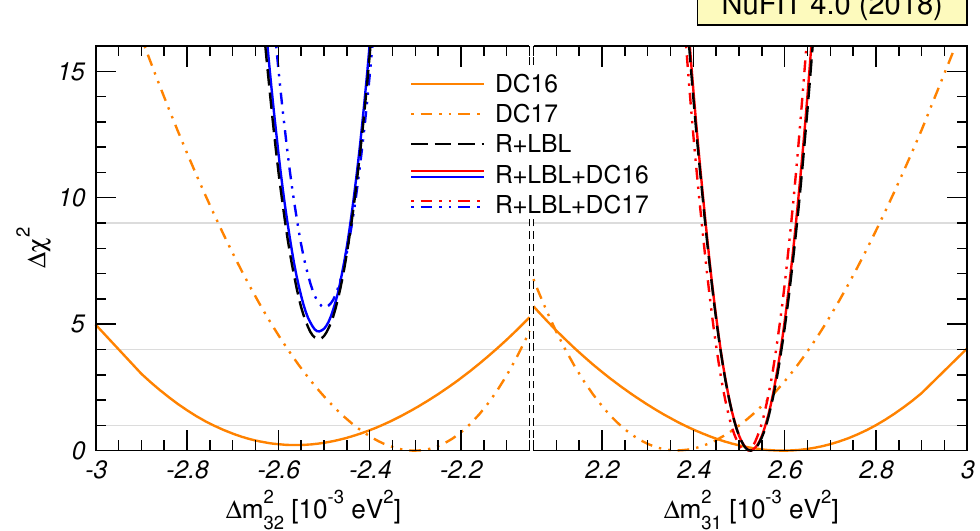
Figure 10 . (cid:1) (cid:31) 2 as a function of (cid:1) m 2 for our reanalysis of Deep-Core 3-years data of refs. [27, 28] 3 ‘ (labeled DC16, solid orange line) and its combination with the global analysis of reactor and LBL experiments (full blue and red lines). The corresponding dash-dotted line correspond to use the (cid:31) 2 table provided by the experiment for the analysis of their three years data in refs. [31, 50] (labeled DC17). See text for